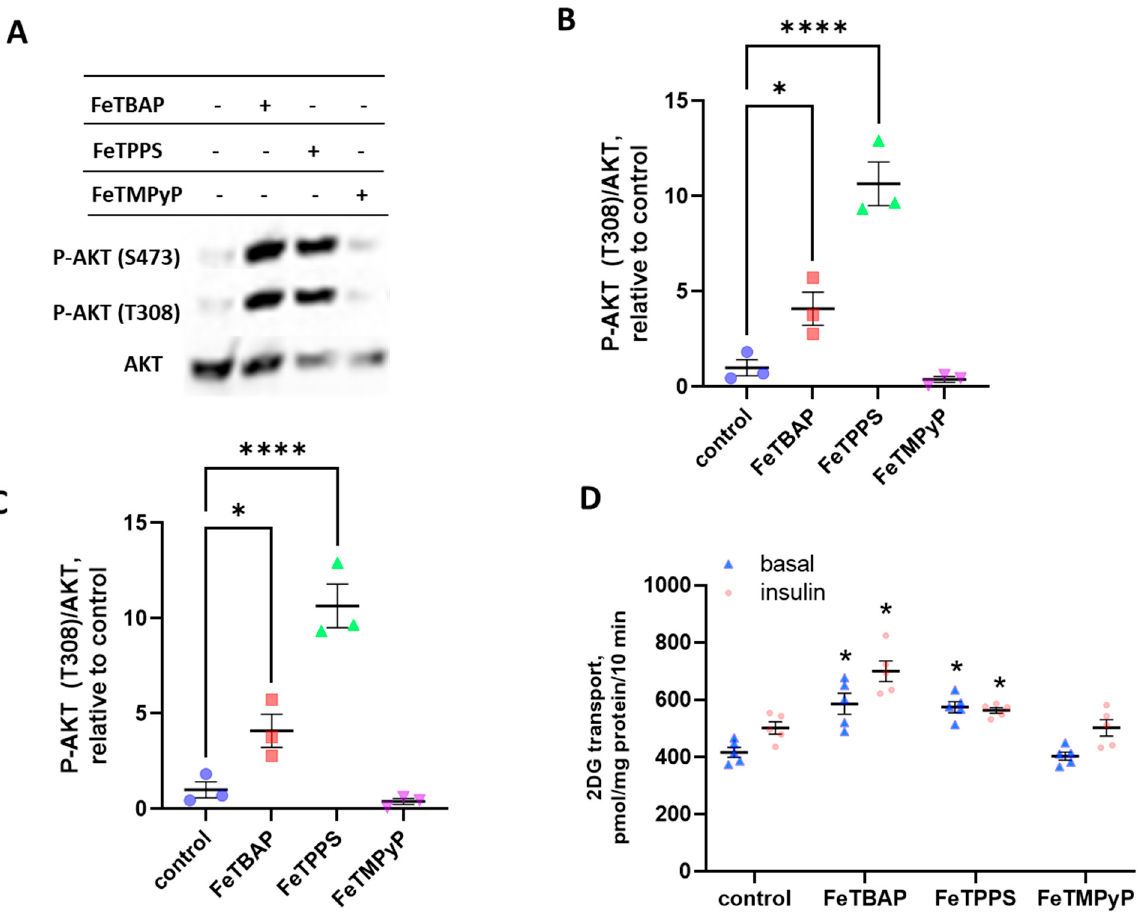
Figure 4. FeTBAP and FeTPPS increase insulin signaling and glucose transport in C2C12 myotubes. C2C12 myotubes were incubated in the absence or presence of 150 µM FeTBAP, FeTPPS, or